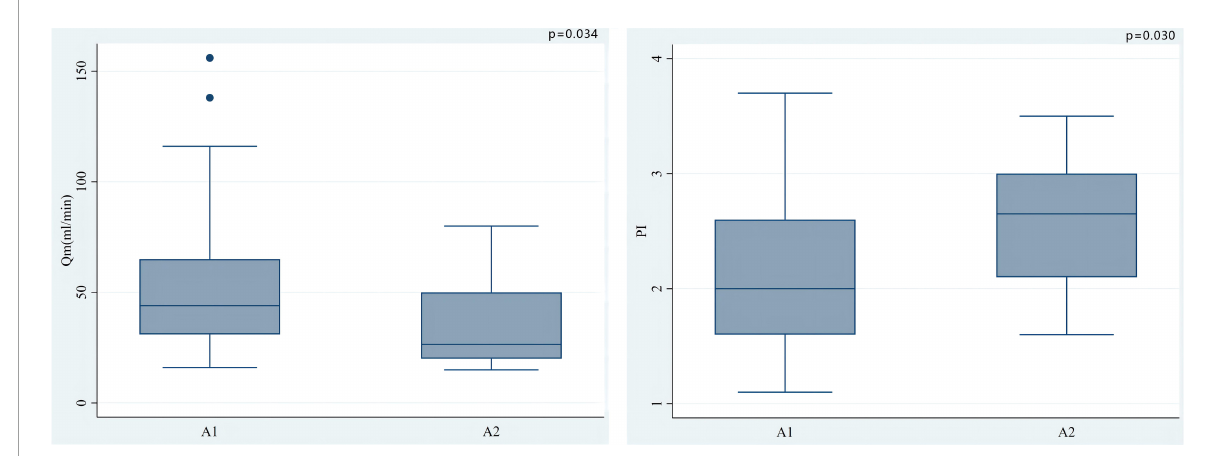
FIGURE3 Among patients who used LITA in situ graft to LAD, there were significant differences in Qm ( P = 0.034) and PI (0.030) between the A1 group and the A2 group. In situ LITA-LAD graft flow increased with the increase of coronary stenosis severity while the PI decreased.